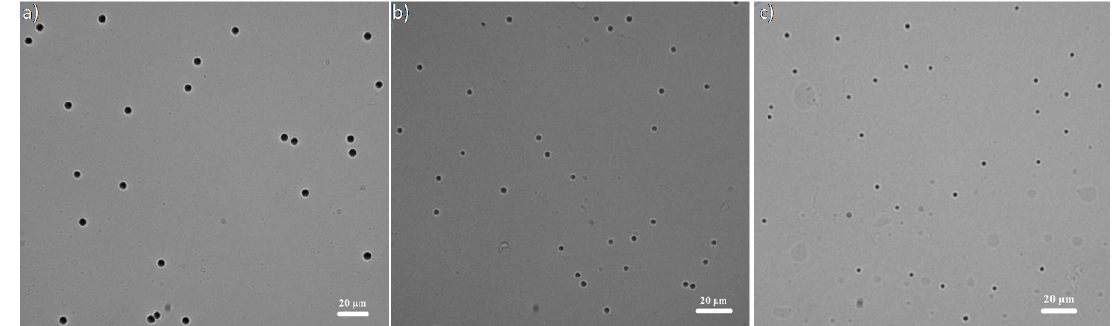
Figure 3. Images of proton tracks on the CR-39 detectors, obtained for a 40× optical microscope magnification: ( a ) 2 MeV; ( b ) 3 MeV and ( c ) 5 MeV proton beam energy.